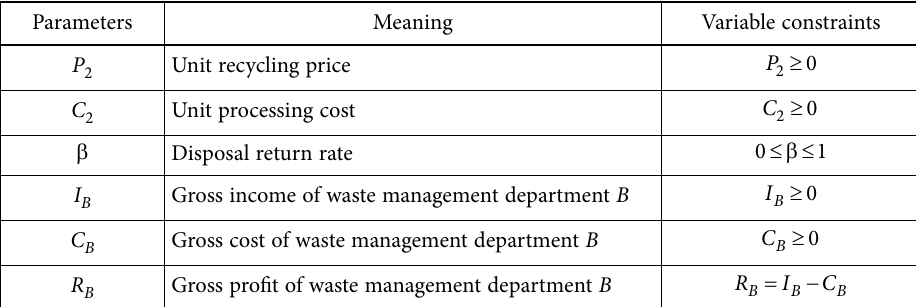
Table 2. Waste management department-related